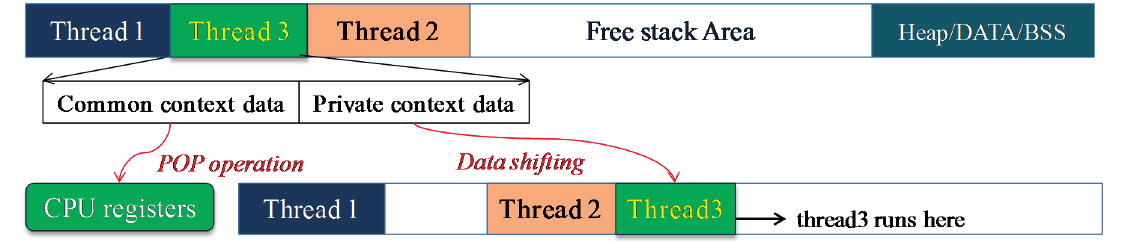
Figure 7. Stack shifting process in LiveOS. Only the private context data rather than the whole context data needs to be shifted during the stack-shifting